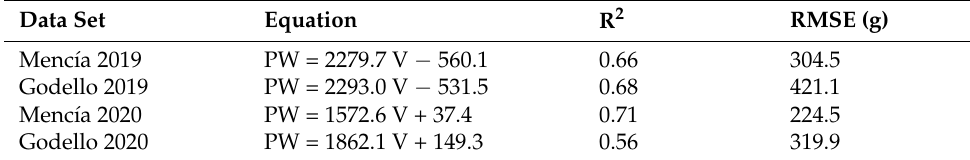
Table 4. Results of leave-one-out cross validation for predicted pruning weight. Data